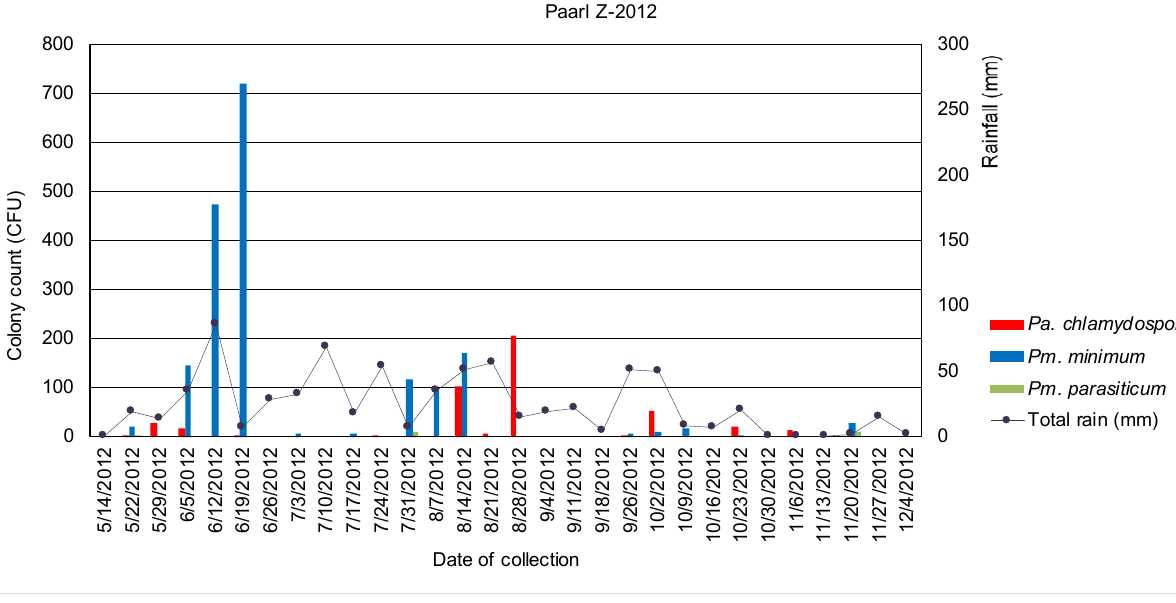
Figure 3. Phaeomoniella and Phaeoacremonium spp. cfu cultured from five vaseline coated microscope slides affixed to the cordons on each of five vines in vineyard Paarl Z, Western Cape province in 2012. The slides were replaced weekly. Each bar represents the total number of cfu cultured on three Petri dishes. Not clear on the graph, Pm. parasiticum detection dates are 22/05, 31/07 and 20/11.